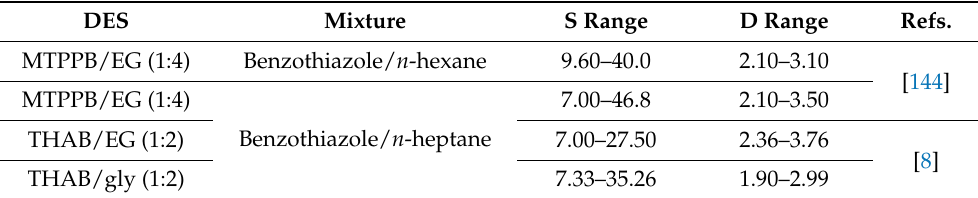
Table 5. Selectivity and distribution ratio (D) for the removal of sulfur and nitrogen compounds using